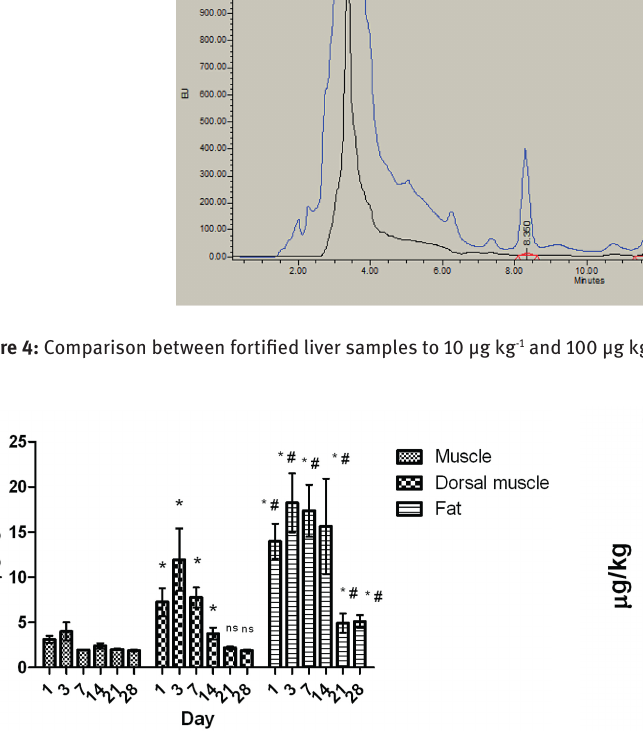
Figure 5: Marker residue concentration of eprinomectin B and fat of cattle treated with pour-on product dose of 1 mL per 10 kg of body weight (500 μg eprinomectin kg -1 Bw) (P ˂ 0.001).